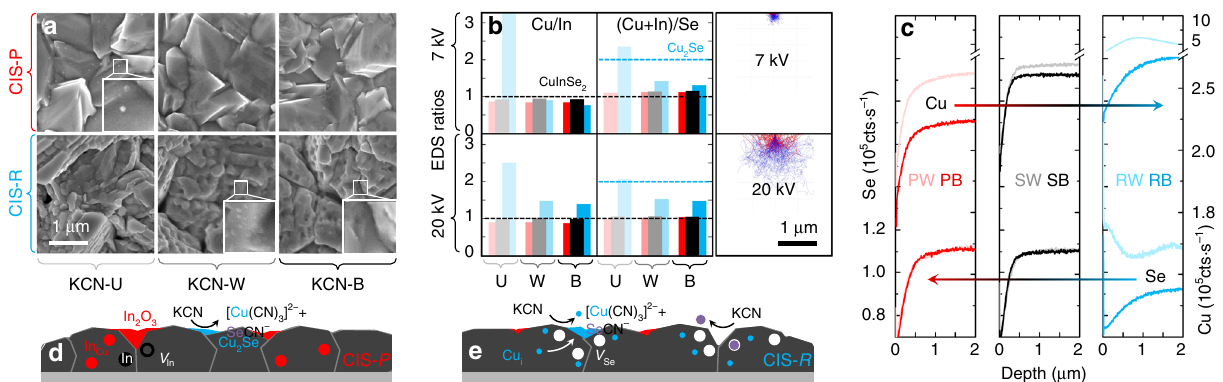
Fig. 5 Composition-dependent CuInSe 2 surface reactivity against KCN at room temperature. a SEM top views of Cu-poor CIS (CIS-P, top row) and Cu- rich CIS (CIS-R, bottom row) fi lms unetched (KCN-U) and after KCN weak (KCN-W) and bold (KCN-B) etchings. The white squares are magni fi cations of selected areas to reveal the presence of Cu 2 Se particles in PU and RW and their absence in RB. b Box plot of Cu/In and (Cu + In)/Se atomic concentration ratios acquired by EDS at 7 kV (top) and 20 kV (bottom) acceleration voltages, entailing beam- fi lm interactions as shown by the corresponding CASINO 73 depth simulations. The dashed lines correspond to the ratios expected from pure stoichiometric CuInSe 2 (grey) and Cu 2 Se (cyan). It is noteworthy that the Cu/In ratio of CIS-R exceeds 1 even at 20 kV, because the sample was intentionally grown under very high Cu fl ux, whereas the initial Cu/In ratio of standard Cu-rich fi lms never exceed 1.3. c Cu and Se SIMS depth pro fi les of CIS-P (red), CIS-S (black) and CIS-R (blue) fi lms subject to KCN-W (light shades) and KCN-B (dark shades). Cu and Se appear to be leached mostly out of CIS-R, whereas CIS-S shows the least compositional deviation. The Se pro fi les of CIS-P and CIS-S are virtually unaffected by KCN etching. d , e Schematic representations of point defect-driven selective leaching by Both EDS and SIMS show that stoichiometric CIS yields the smallest compositional change upon KCN etching.